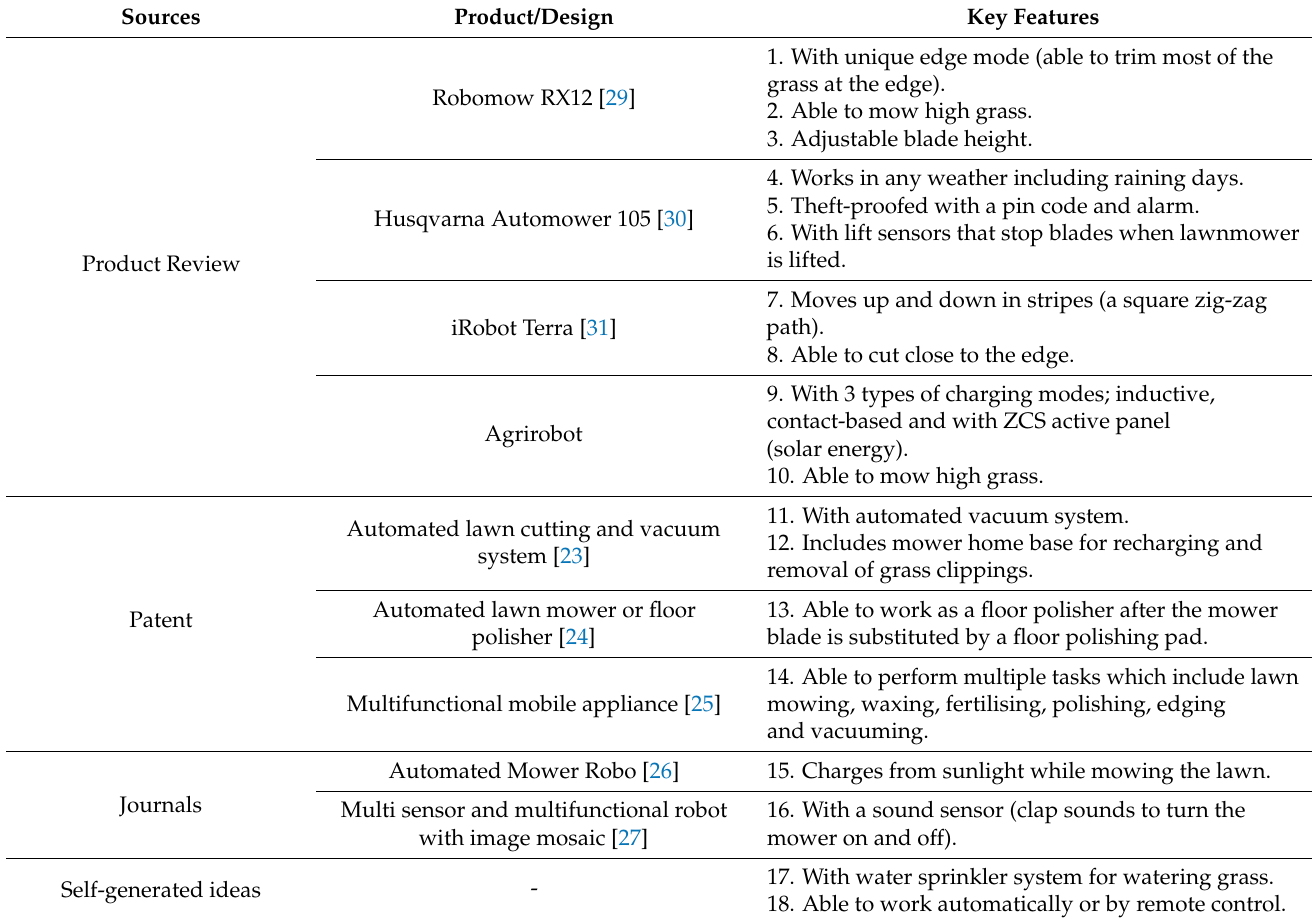
Table 9. List of features from different